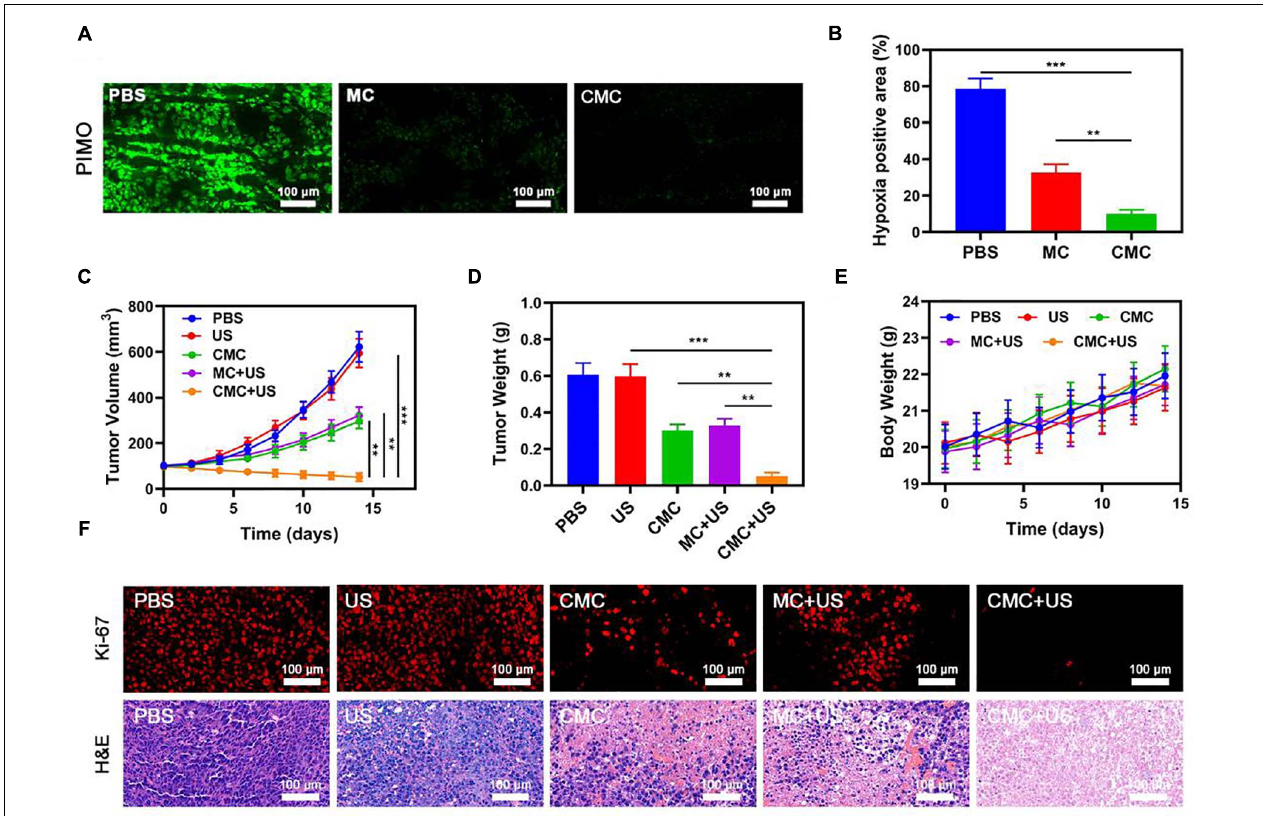
FIGURE 3 | (A) Representative images of tumor tissue sections stained with anti-PIMO (green) following the indicated treatments. (B) Fraction of pimonidazole (PIMO) positive hypoxic area in different groups ( n = 3). Changes in tumor (C) volume and (D) were monitored in mice subjected to the indicated treatments ( n = 5). (E) Changes in murine body weight were monitored over time in the indicated treatment groups ( n = 5). (F) Tumor sections from the indicated treatment groups were subjected to Ki-67 or H&E staining. ** P < 0.01, *** P < 0.005; Student’s t -test.